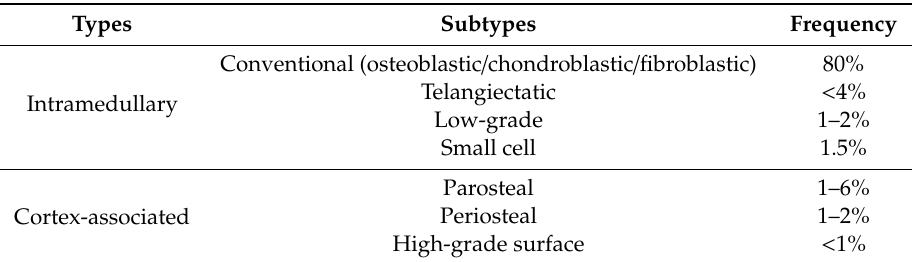
Table 3. Classification of Osteosarcoma